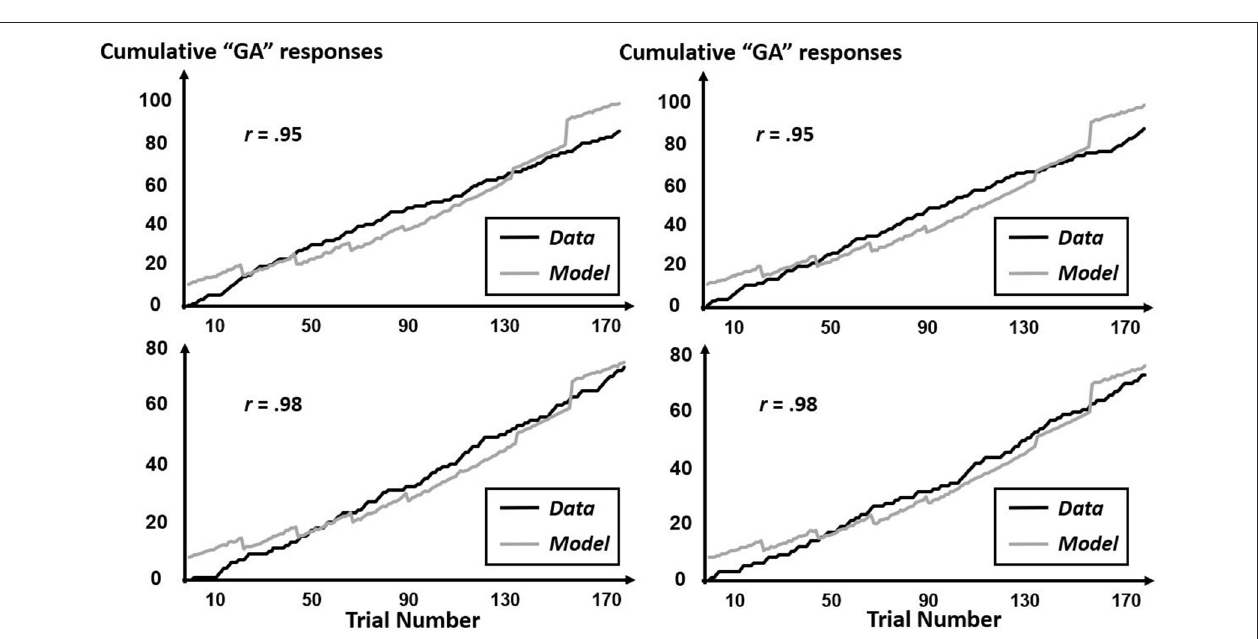
FIGURE 8 | Cumulative “GA” judgments and corresponding model predictions for four individual participants in the tone context. To depict the full range of regression-model performance in the tone condition, we include individual-participant plots from the two participants for whose data the model fit worst (top two panels) as well as from the two participants for whose data the model fit best (bottom two